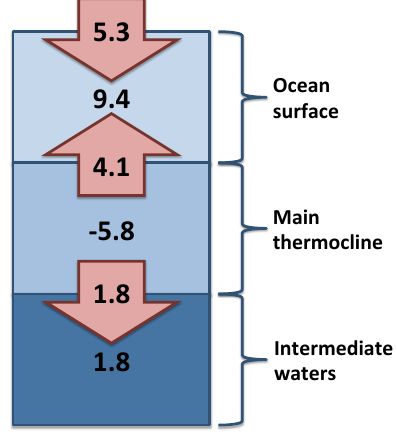
Figure 4. Hypothesized Pacific heat budget during El Niño events. The blue blocks are the ocean surface (0–110m), main thermocline (120–380m), and intermediate water (400–2000m) layers. The red arrows are heat exchanges between the ocean layers or with the overlying atmosphere. Black values are either the total ocean heat storage within the layers as given by Argo data or the required heat exchanged between them under the stated assumptions of no transports between ocean basins and no contributions from the deep ( > 2000m) ocean. Units are ZJ per unit MEI. (Note that all arrows and signs, shown here for El Niño, would be reversed for La